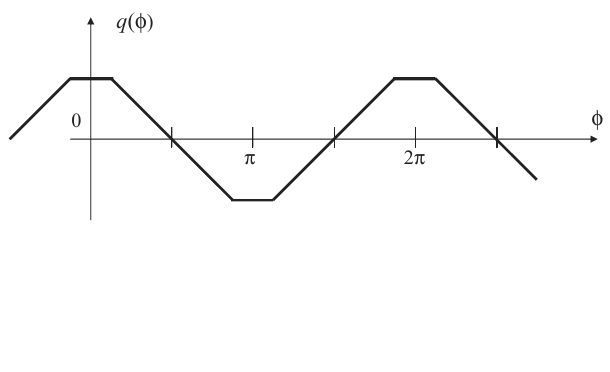
Figure 8. Relation between time correlation and phase difference with non-integration